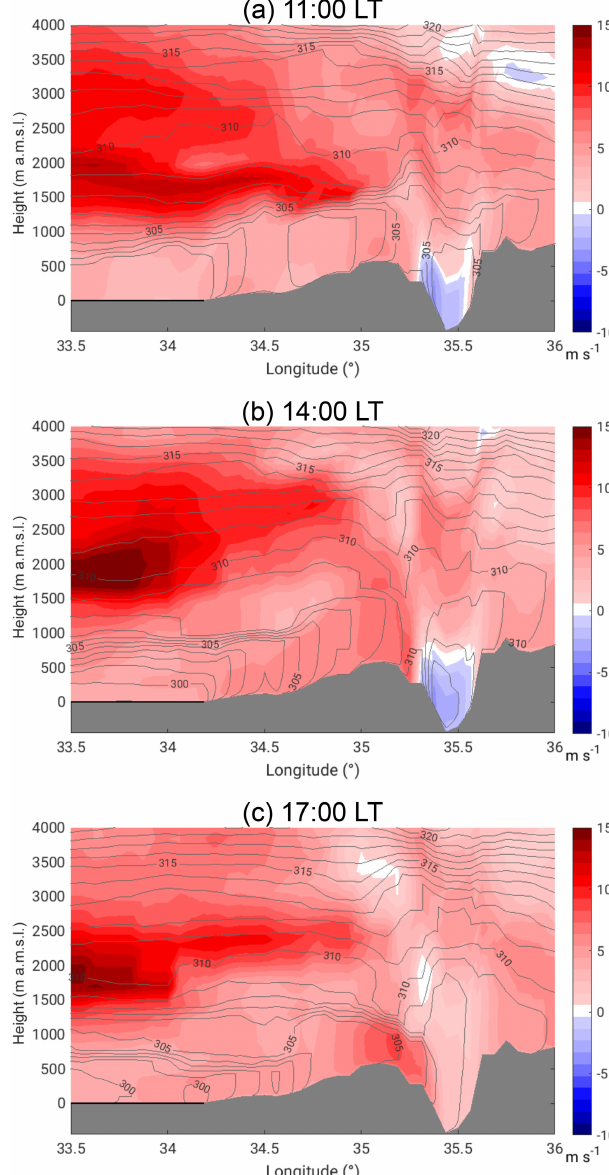
Figure 10. West–east cross section of specific humidity (coloured) and potential temperature (isolines) at the latitude of Masada (31.3125 ◦ N) from COSMO-EU analysis data for 16 August 2014.